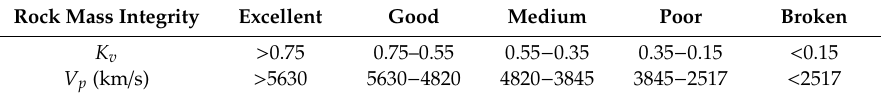
Table 3. Relationship between the rock mass integrity, K v and V p .